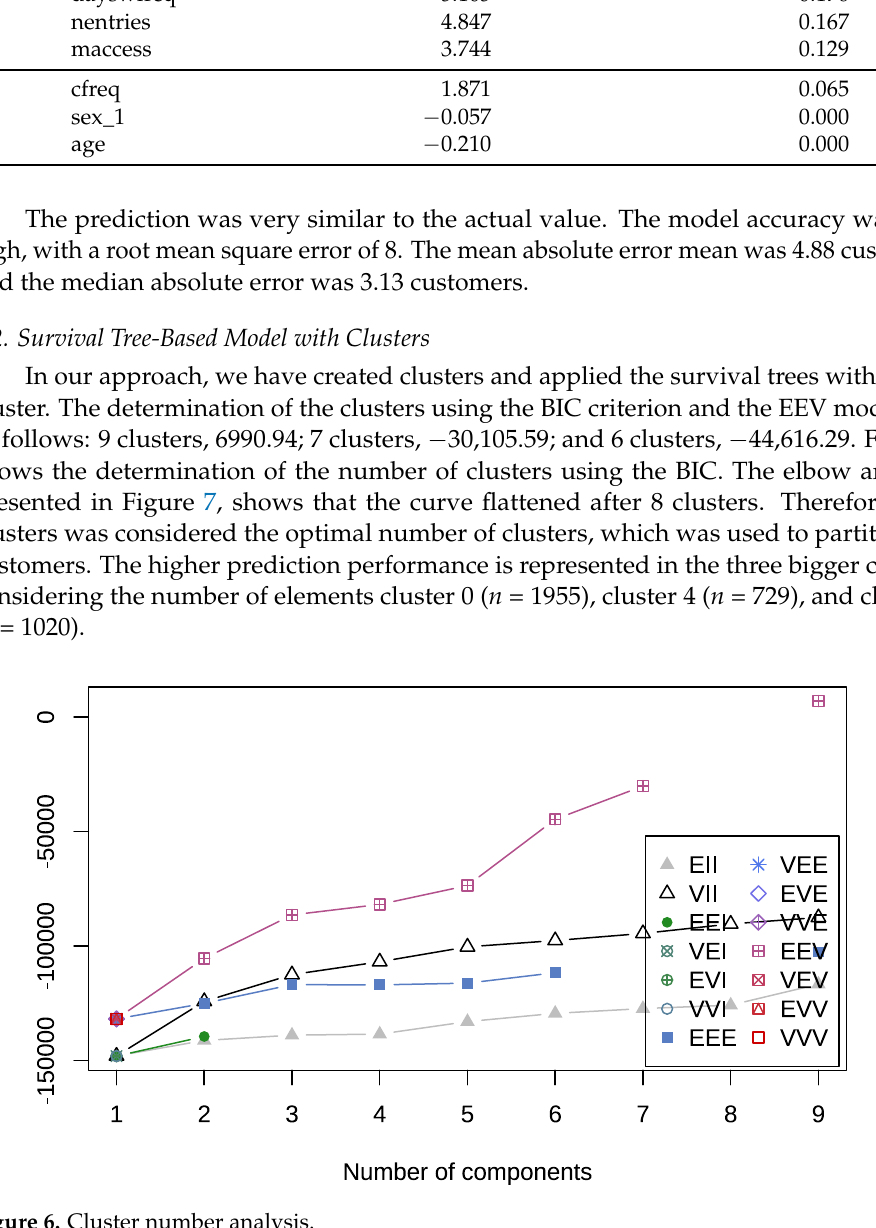
Figure 6. Cluster number